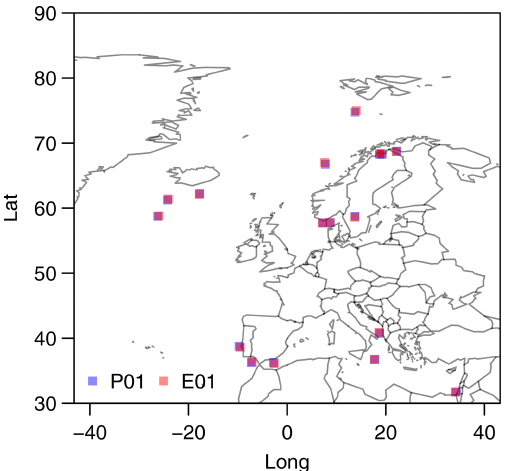
Figure 1. Map of the reconstruction domain and the proxy predic- tors: for the pseudo-proxy setup (blue), experiment P01, and for the main proxy setup (red), experiment E01. Please note the small offset between the proxy locations and their pseudo-proxy counterparts on the discrete model